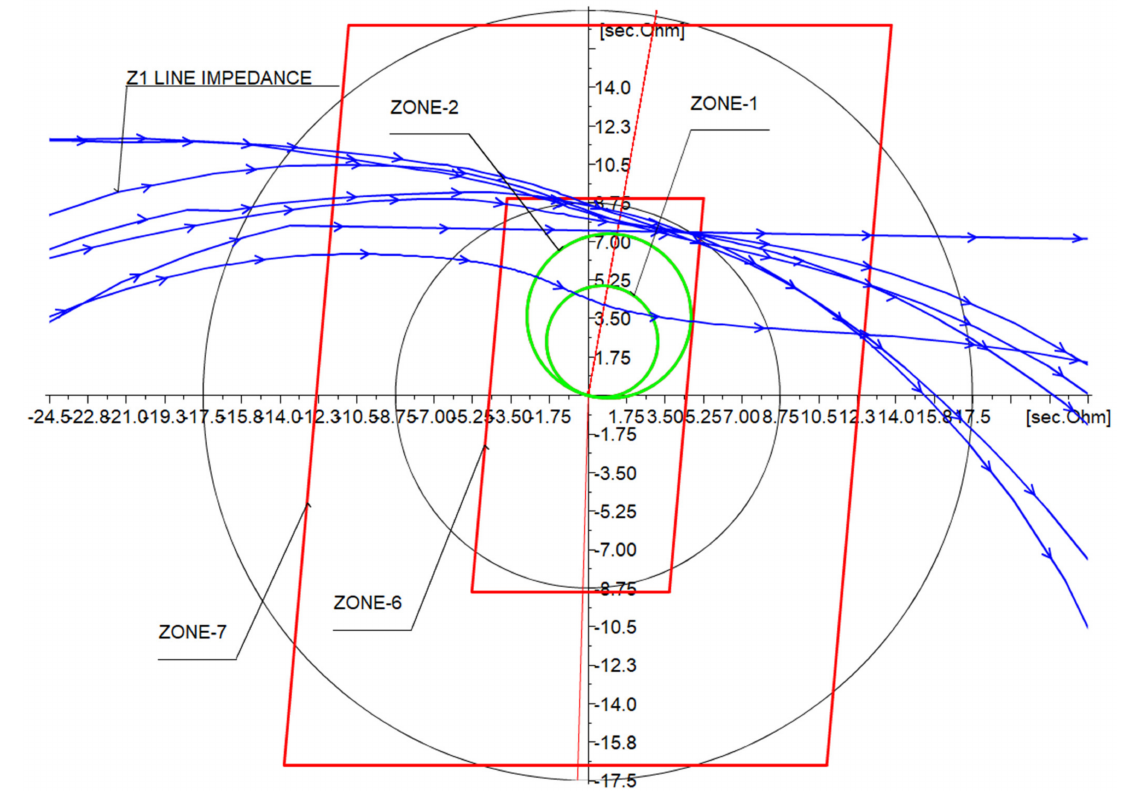
Figure 25. Results of the power swing ( R-X plane) considering the existing OOS protection installed at Line 203.